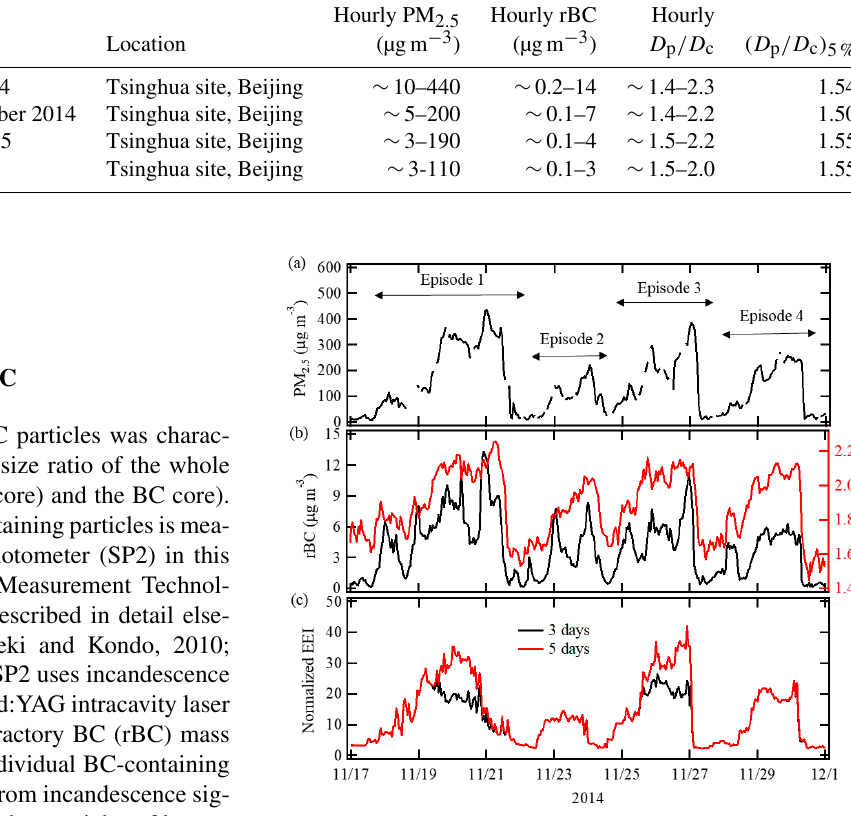
Figure 1. Time series of the PM 2 . 5 concentration, rBC mass con- centration, D p /D c ratio of BC-containing particles and the hourly EEI for BC transported to the observation site for 3-day and 5-day back-trajectories during the BJNOV2014